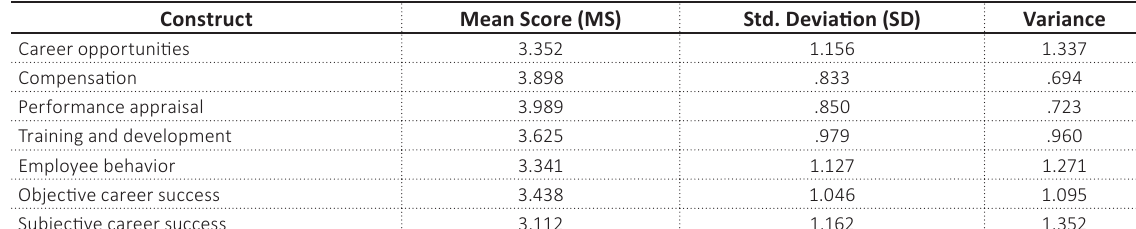
Table 2. Descriptive analysis